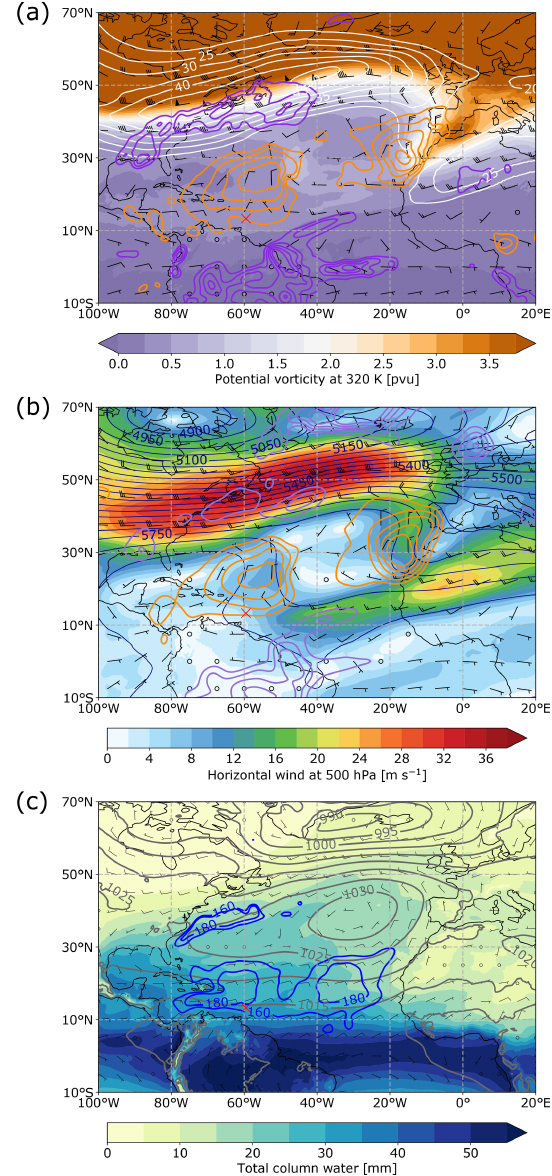
Figure 5. Overview of atmospheric flow conditions, time-averaged for the period 25 January to 17 February 2018 from hourly ERA5 reanalyses. (a) Upper-level flow conditions at 320K with poten- tial vorticity (colours), horizontal wind speed (white contours from 20 to 50ms − 1 in steps of 5ms − 1 ), wind barbs (black) and verti- cal wind ω (orange contours for descent from 0.04 to 0.1Pas − 1 in steps of 0.02Pas − 1 and violet contours for ascent from − 0 . 1 to − 0 . 04Pas − 1 in steps of − 0 . 02Pas − 1 ). (b) Flow conditions at 500hPa with horizontal wind speed (colours) and geopotential height (blue contours). Wind barbs and vertical winds at 500hPa as in (a) . (c) Near-surface flow conditions with sea level pressure (grey contours), wind barbs at 900hPa (grey), accumulated surface evap- oration E during the period (blue contours; in millimetres, positive upward) and average total column water (colours). The red cross indicates the position of Barbados. The contours of ω and E were smoothed with a Gaussian filter for better readability of the